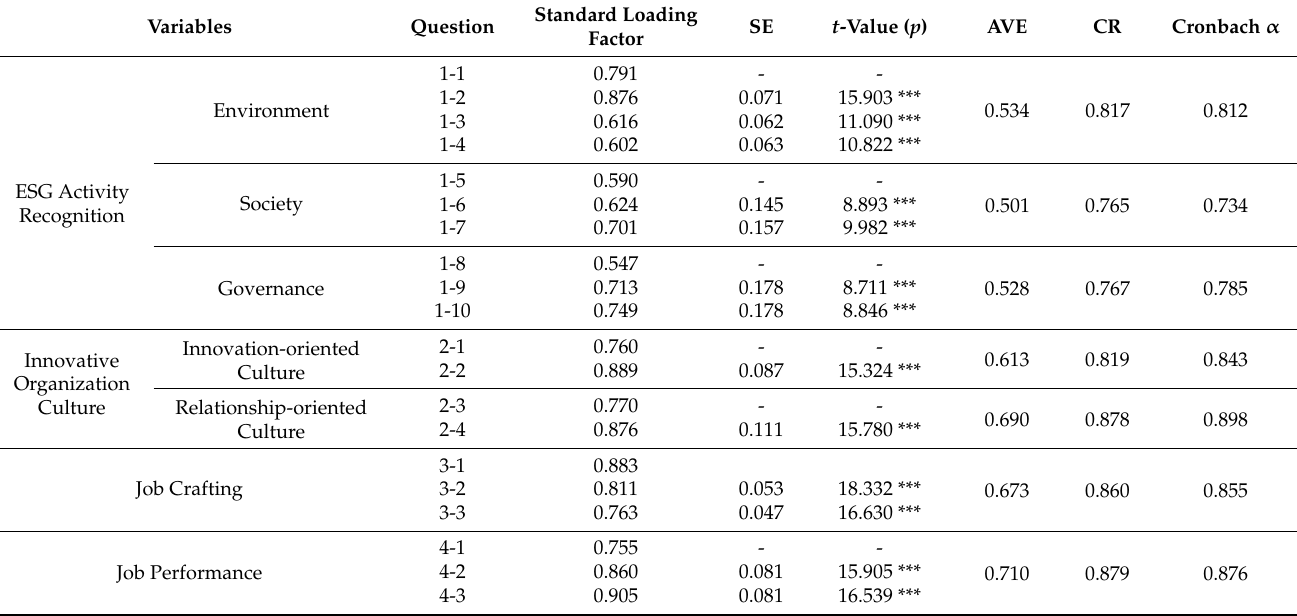
Table 3. Results of reliability and convergent validity test.